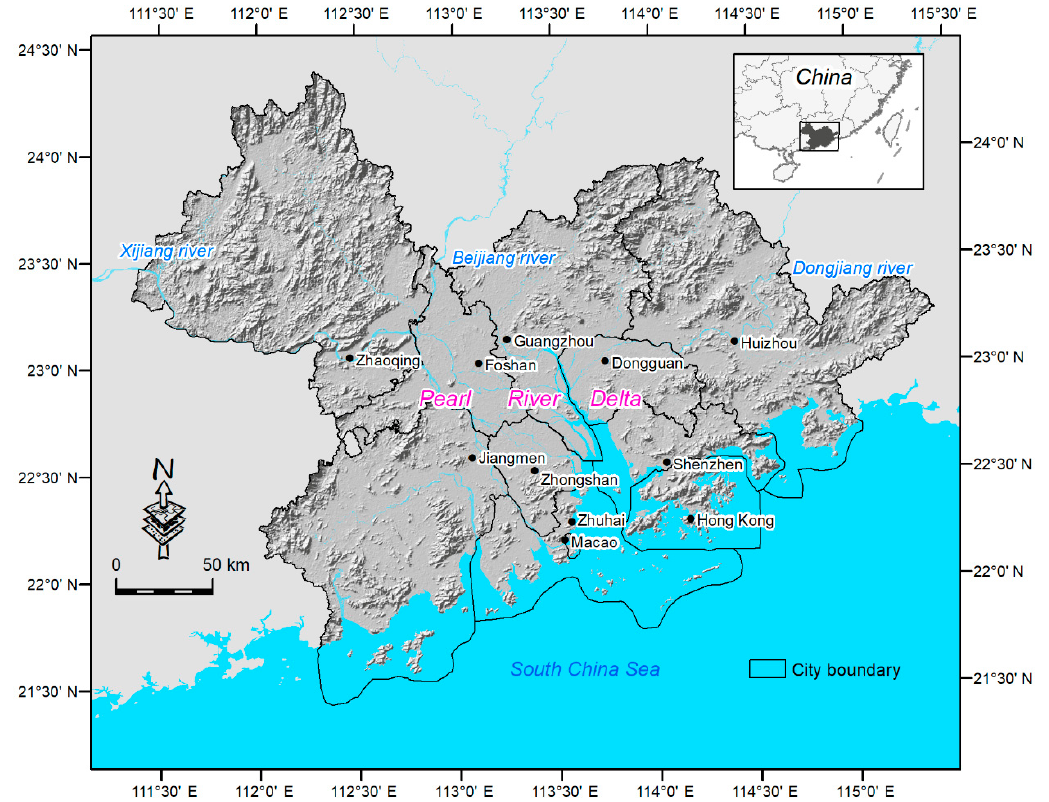
Figure 1. Location of the study area: the Guangdong–Hong Kong–Macao Greater Bay Area.